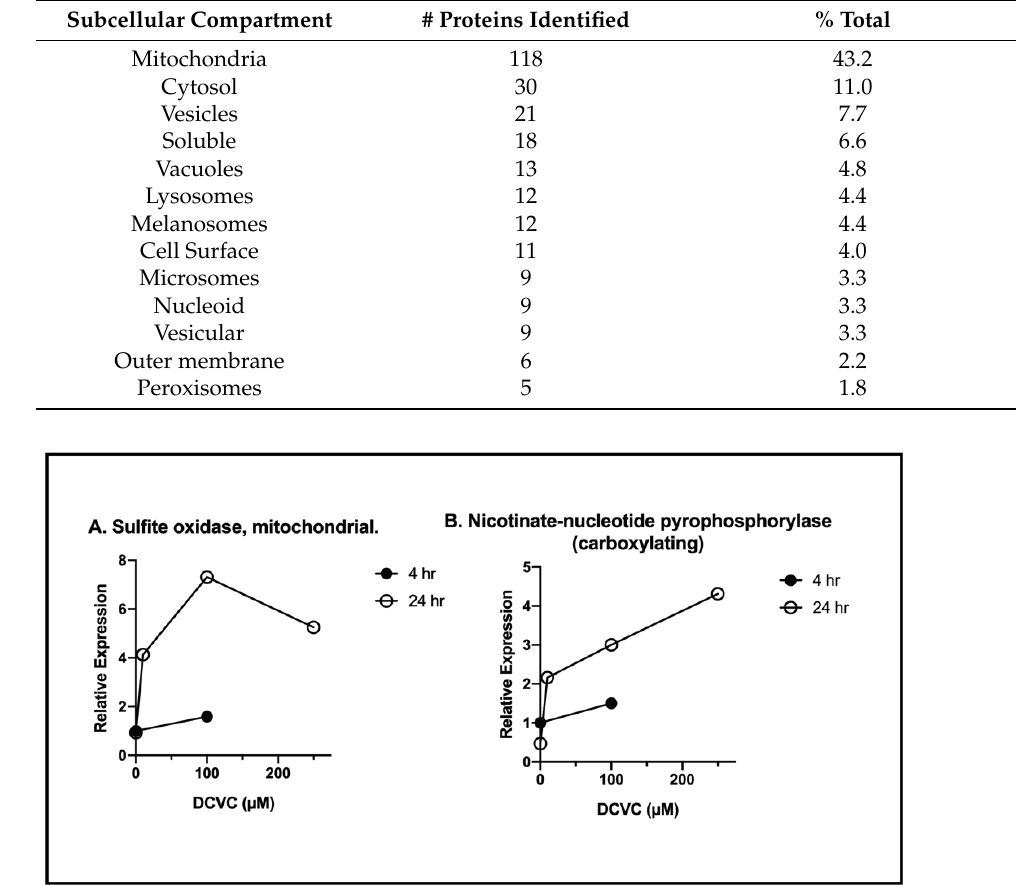
Figure 10. Two mitochondrial proteins identified in culture media of human proximal tubular (hPT) cells exposure to S -(1,2-dichlorovinyl)-L-cysteine (DCVC) (10, 100, or 250 µM) for 4 or 24 h. Primary cultures of hPT cells were incubated with either a culture medium (=control) or DCVC, and samples from the extracellular fluid were analyzed using TMT TM multiplexing and LC–MS/MS analysis, as described in the legend of Table 3. Results are shown as expression levels relative to that in the 4-h control samples and are from a single set of analyses.